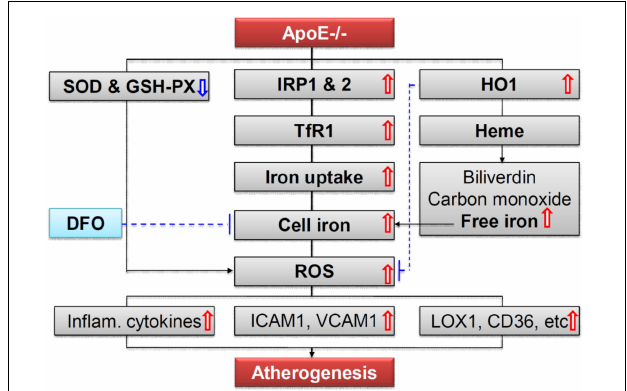
FIGURE 7 | A hypothetical scheme for the role of iron in ApoE deficiency-induced atherosclerosis. The increased iron accumulation in the aortic tissues (AET) may be mainly due to increased cell-iron uptake via IRP/TfR1 pathway. Increased ROS production, induced mainly by increased iron and possibly also partly by reduction in SOD and GSH-PX enzymes, plays an important role in endothelial activation and consequent monocyte recruitment to the arterial intimae, via up-regulation of the expression of cellular adhesion molecules ICAM1 and VCAM1, main ox-LDL receptor of endothelial cells LOX-1, important receptor for oxidized lipoproteins CD36, NF- κ B phosphorylation, and pro-inflammatory cytokines TNF α , IL-1 β , and IL-6, in the aortic tissues of